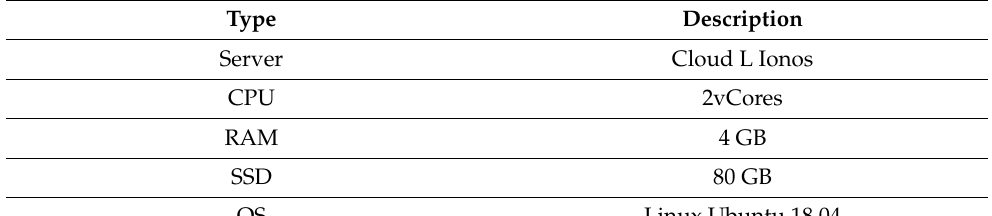
Figure 4. Example of pedestrian flows from the data obtained in the outdoor experimental tests. The video is available as supplementary material. The image shows the number of pedestrians that moved from location x to location y in periods of time equal to 15 min. Note that the number indicates the street crossroads from crossroads 0 on the right to crossroads 7 on the left, as shown in the map above, and the sub-index at each crossroad designates the street; for instance, 7.2 means street 2 in crossroad 7. Table 2. Features of the cloud server used in the real deployment.